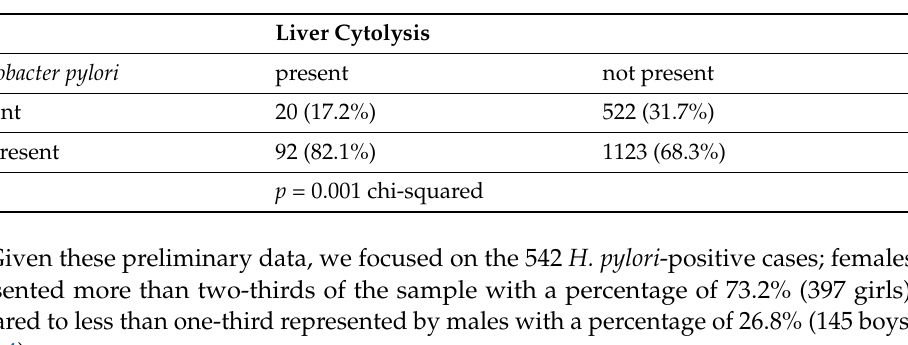
Table 3. H. pylori and liver